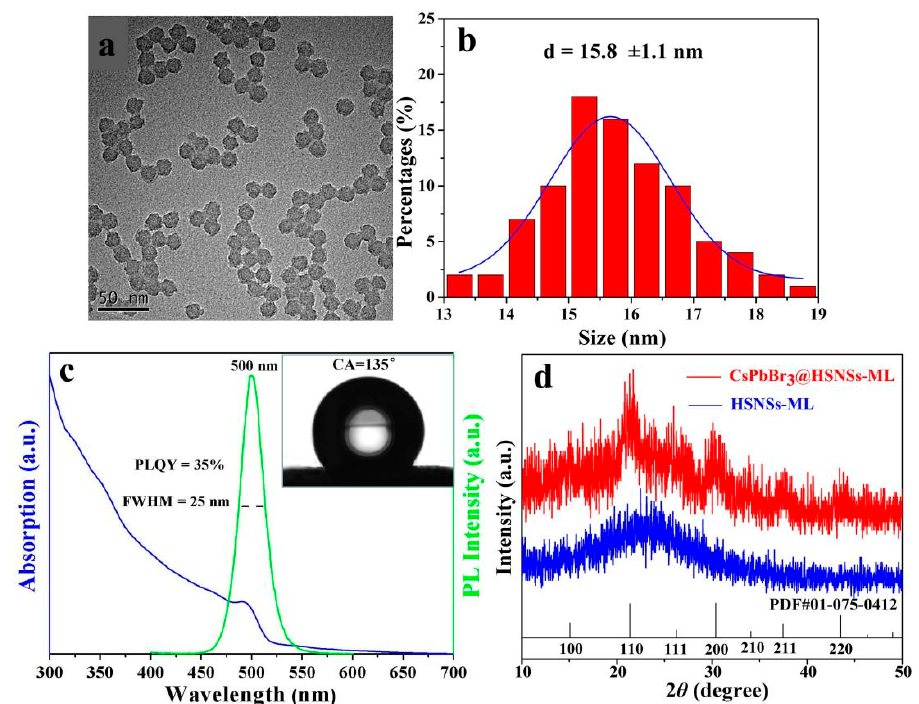
Figure 3. ( a ) Representative TEM images of the as-prepared CsPbBr 3 @HSNSs-ML NPs; ( b ) the di- ameter distribution histogram of CsPbBr 3 @HSNSs-ML NPs by calculating 80 individual nanospheres; ( c ) absorption and PL spectra of the CsPbBr 3 @HSNSs-ML NPs; insets in ( c ) show the water CA (bottom); ( d ) XRD pattern of CsPbBr 3 @HSNSs-ML.